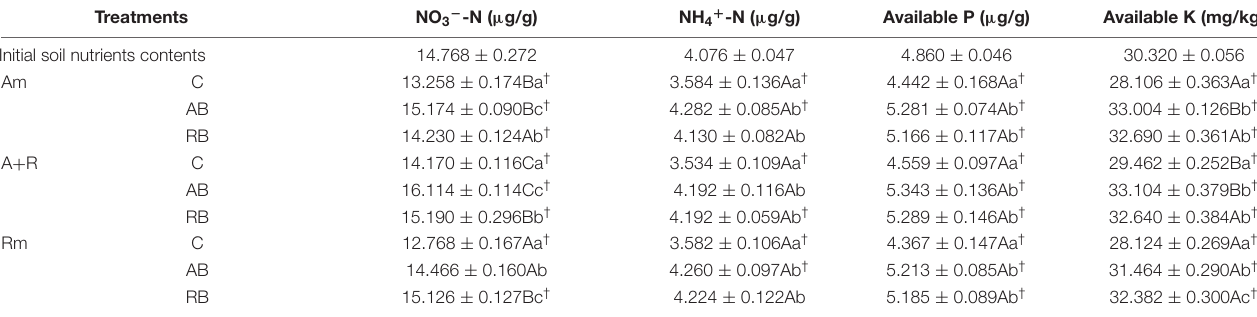
TABLE 2 | Soil characteristics under different